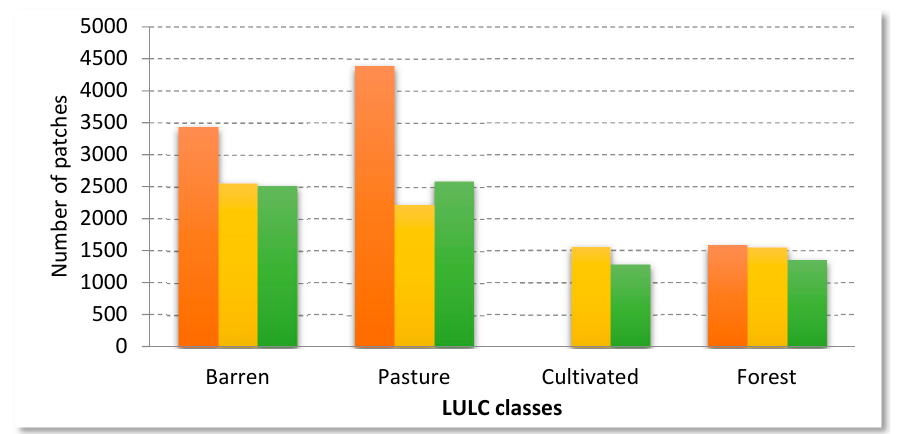
Figure 5. Landscape metrics at class level for Number of patch (NP) in HSCZ for years 1984, 1998, and 2015.